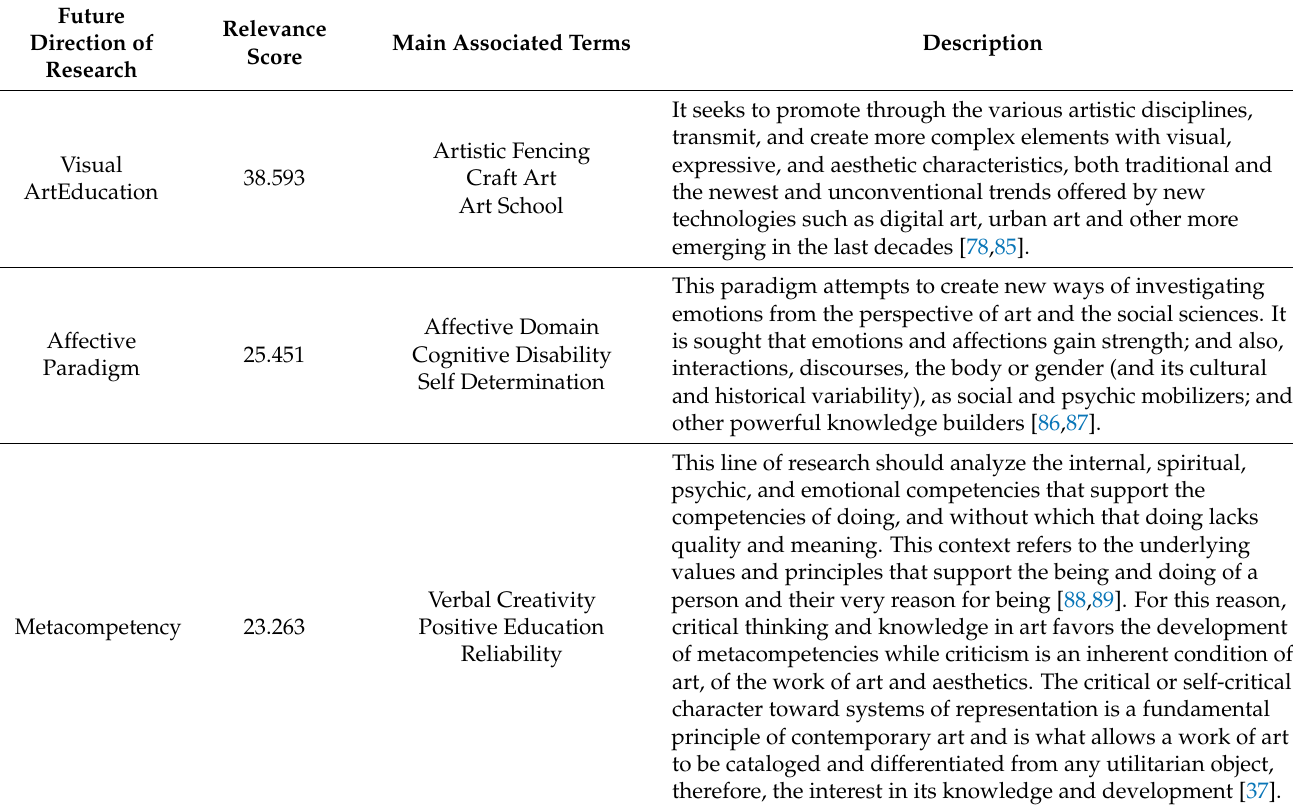
Table 4. Future research